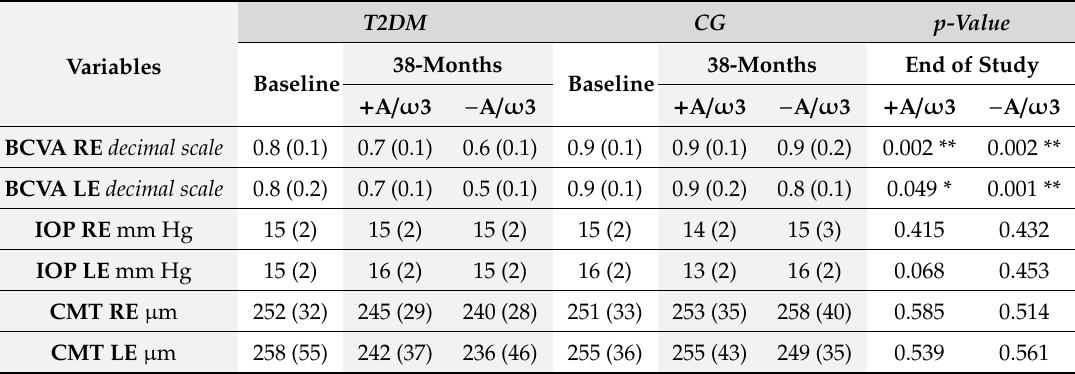
Table 3. Ophthalmologic data in the supplemented vs. The non-supplemented participants. T2DM Baseline